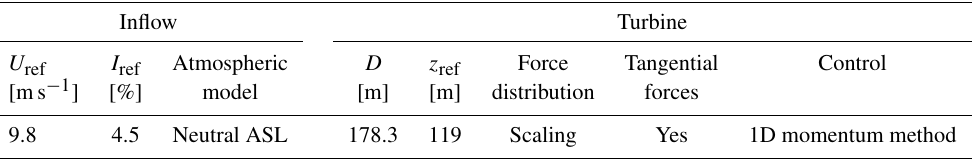
Table 7. Simulation parameters for the aligned-row case from TotalControl. The AD scaling and 1D mom’m control methods are described in detail by van der Laan et al. (2015a).